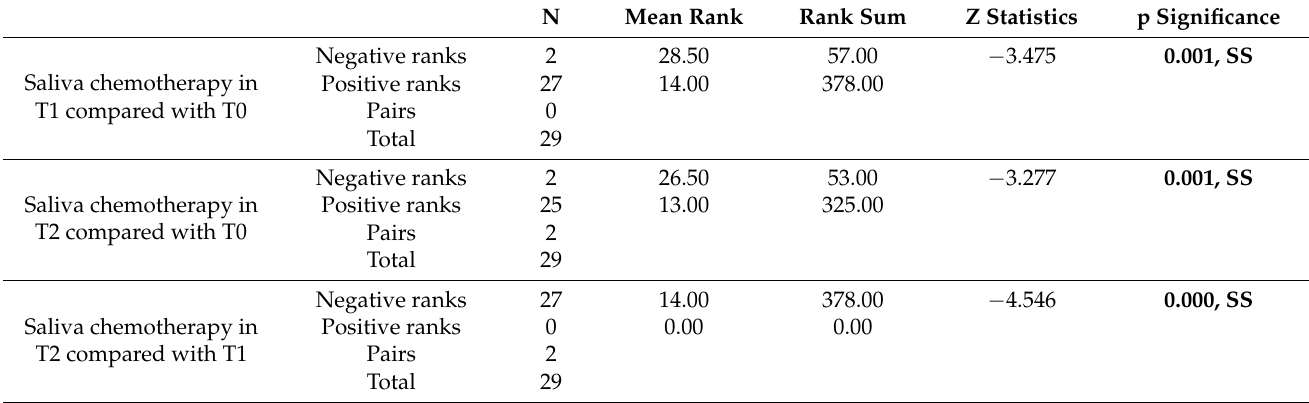
Table 3. Wilcoxon test for chemotherapy concentration comparison in T0, T1, and